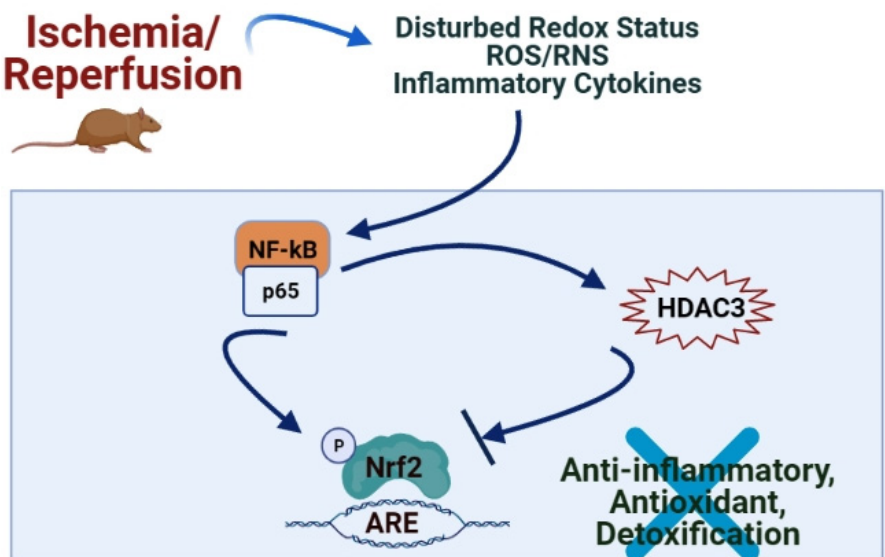
Figure 2. During I/R injury, activation of NF κ B-p65 occurs, which in cooperation with HDAC3, negatively regulates Nrf2-ARE signaling and promotes oxidative stress-induced cell death. (ARE: Antioxidant Response Element, HDAC3: Histone Deacetylase 3, Nrf2: Nuclear factor (erythroid-derived 2)-related factor 2).